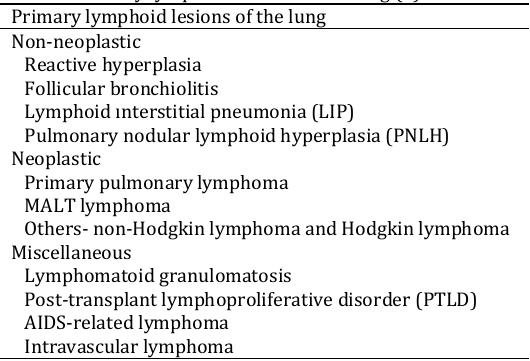
Table 1. Primary lymphoid lesions of the lung (3) Primary lymphoid lesions of the lung Non-neoplastic Reactive hyperplasia Follicular bronchiolitis Lymphoid ınterstitial pneumonia (LIP) Pulmonary nodular lymphoid hyperplasia (PNLH) Neoplastic Primary pulmonary lymphoma MALT lymphoma Others- non-Hodgkin lymphoma and Hodgkin lymphoma Miscellaneous